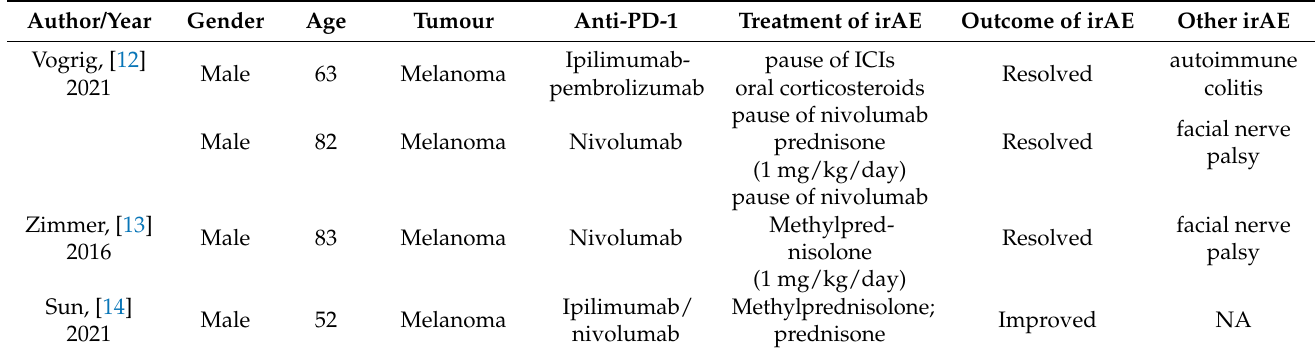
Table 1. Cases of abducens neuritis reported with anti-PD-1